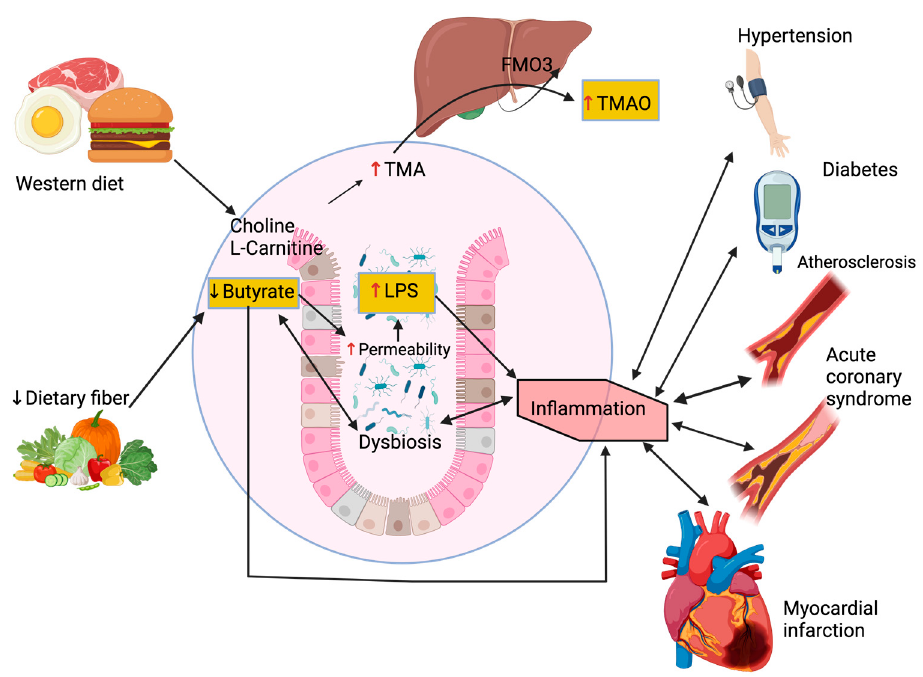
Figure 3. Role of the gut microbiome in the incidence of atherosclerotic cardiovascular disease. A low-fiber diet is associated with a decreased production of the short-chain fatty acid butyrate, subsequently aggravating dysbiosis as well as sustaining local and systemic inflammation through leakage of bacterial toxins, notably LPS. A modern western diet rich in red meat promotes bacterial production of TMA, which is then oxidized to the pro-atherosclerotic metabolite TMAO in the liver. FMO3: flavin-containing monooxygenase 3, LPS: lipopolysaccharides, TMA: trimethylamine, TMAO: trimethylamine N-oxide.